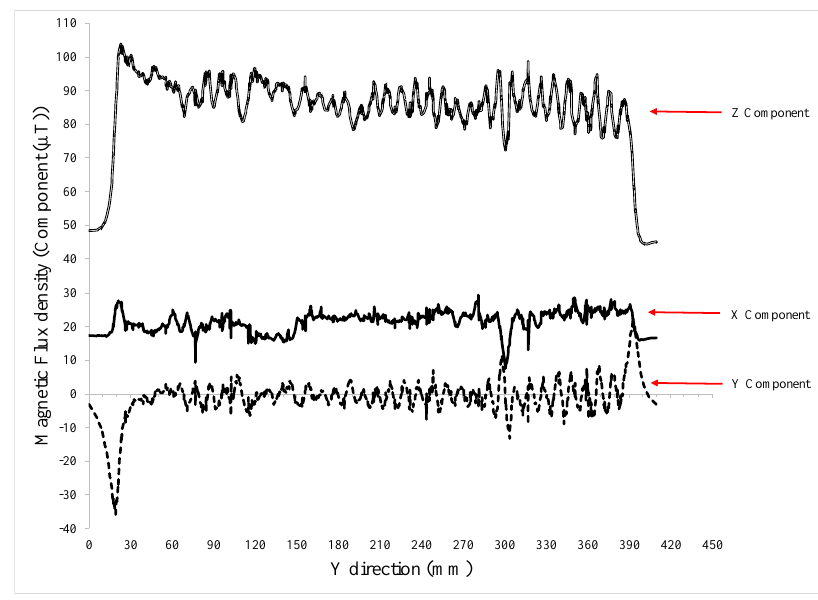
Figure 6. Values of different components (X, Y and Z) of the magnetic flux densities in the Y direction at the surface of the rebar (initial mesh of the rebar and box).